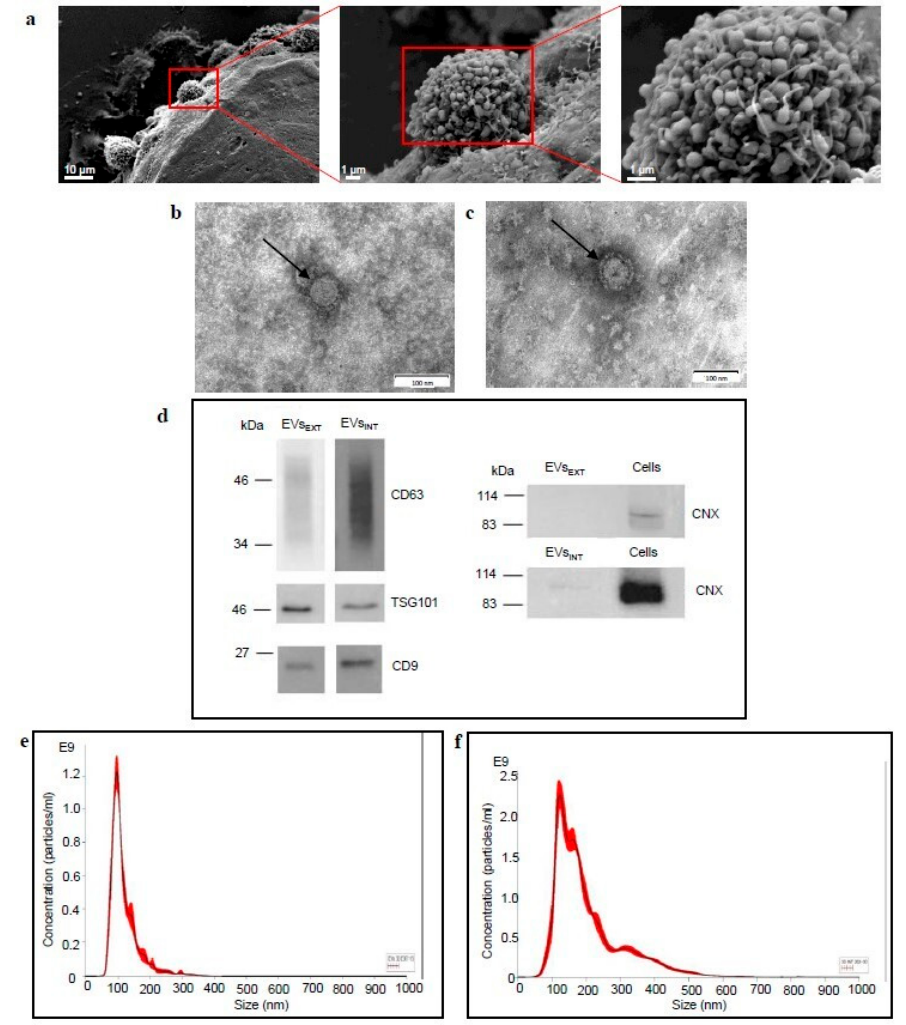
Figure 4. Spheroids release of EVs EXT and EVs INT . ( a ) SEM images, representative of several observations, showing EVs release from the spheroid surface. Each red rectangle encloses the microscope field shown, in higher magnification, on the image on the right. The lower magnification on the left shows the outer surface of spheroid; higher magnifications highlight the release of EVs from cell surface. Size bar is 10 µ m in the image on the left, 1 µ m on other images. ( b ) Ultrastructural TEM image of EV EXT ; the size bar is 100 nm. ( c ) Ultrastructural TEM image of EV INT ; the size bar is 100 nm. In b and c the arrows point to EVs. ( d ) Western blots of CD63, TSG101, CD9 and calnexin (CNX) on EVs EXT and EVs INT samples. For CNX, that must be negative in EVs, total cell proteins are showed as positive control. ( e ) Representative NTA profile of EVs EXT . ( f ) Representative NTA profile of EVs INT